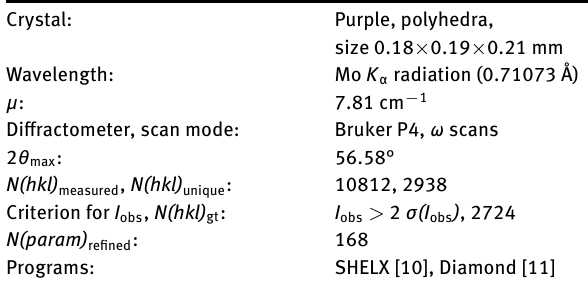
Table 2: Fractional atomic coordinates and isotropic or